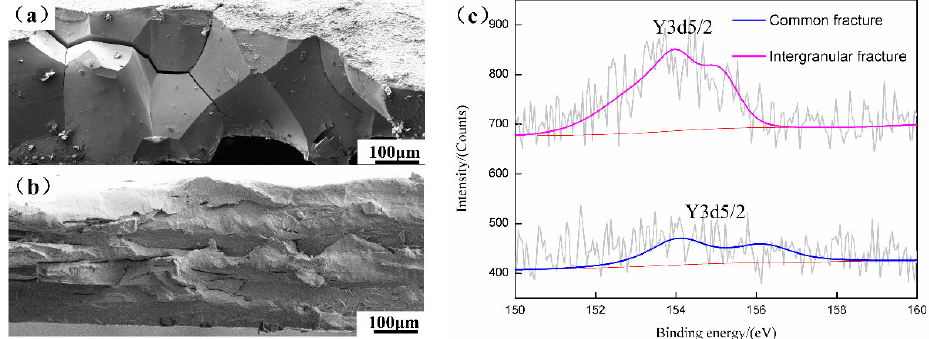
Figure 4. XPS in fracture of the final sheets containing 0.012 wt% Y: ( a ) intergranular fracture; ( b ) transgranular fracture; and ( c ) XPS map.